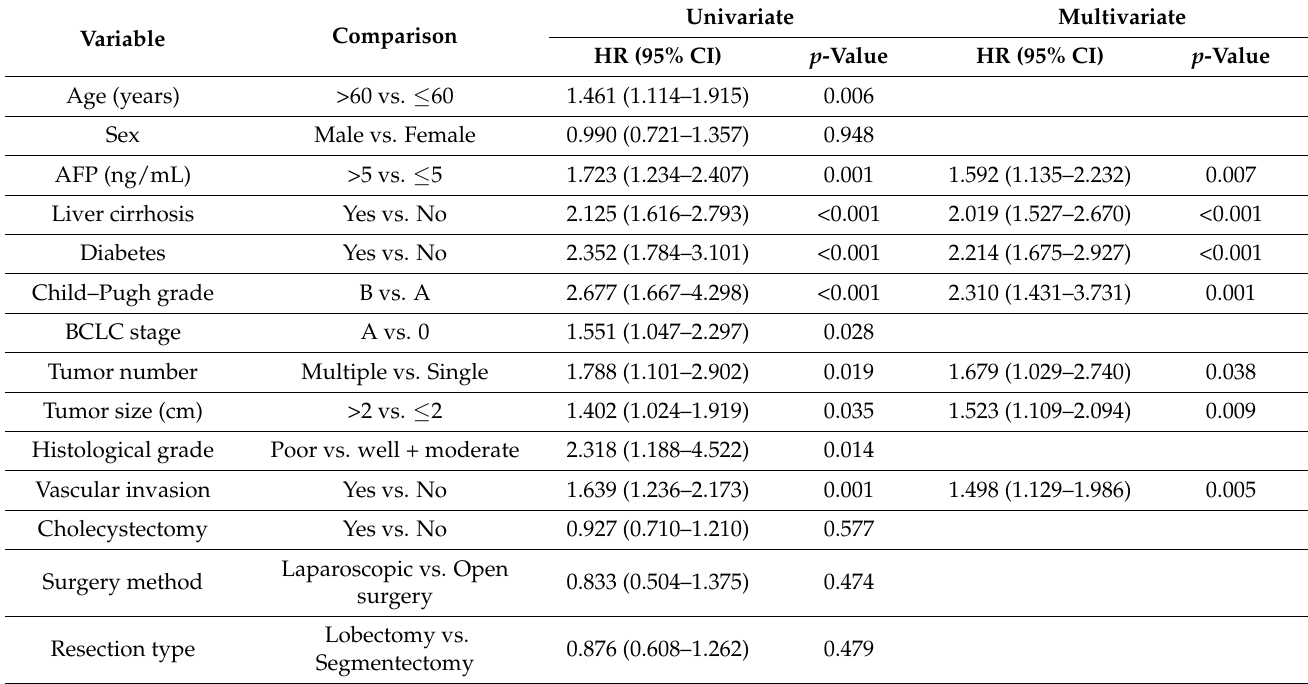
Table 3. Univariate and multivariate analysis of overall survival for propensity score-matched patients with BCLC 0/A stage